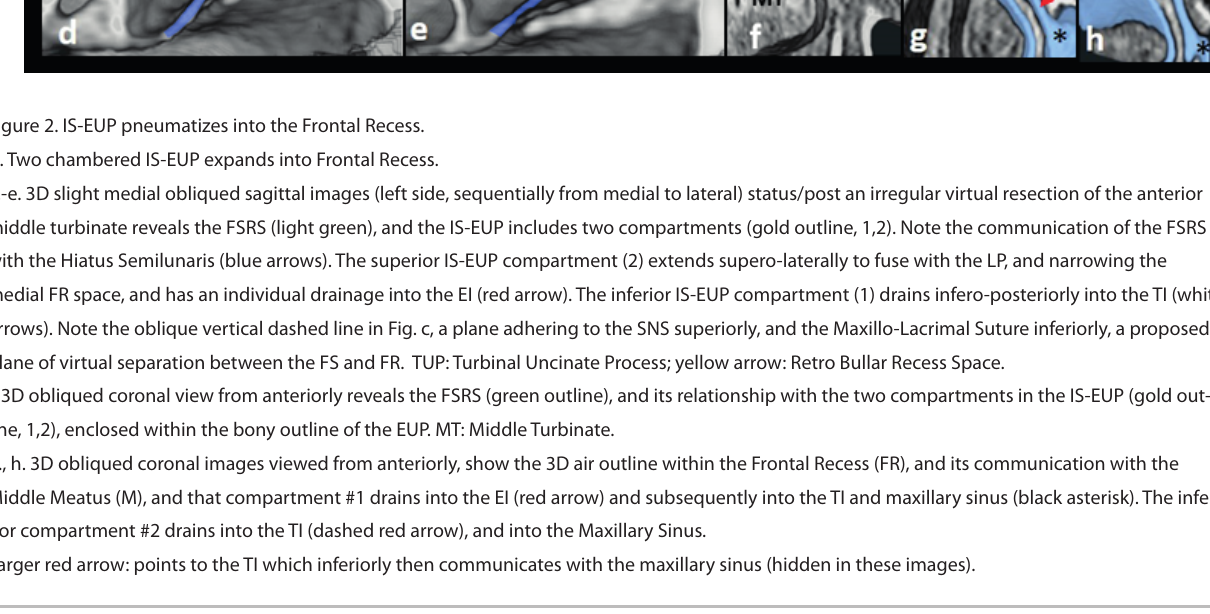
mucus clearance and exchange of air (42) . Pianta et al. referred to air spaces within their ABC classification, not cells (44) . Arun et